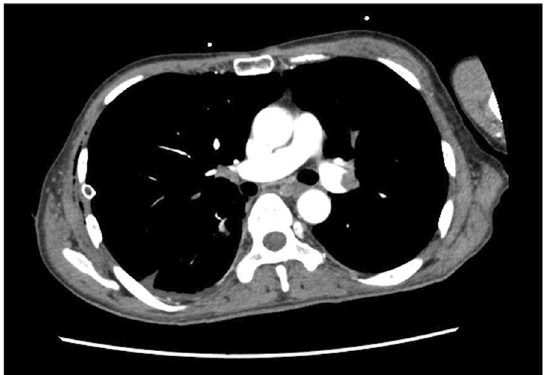
Fig. 3 Enhanced CT scan findings after sudden dyspnea and dropped SpO 2 . The enhanced CT scan showed Pulmonary thromboembolism due to thrombus in the left main pulmonary